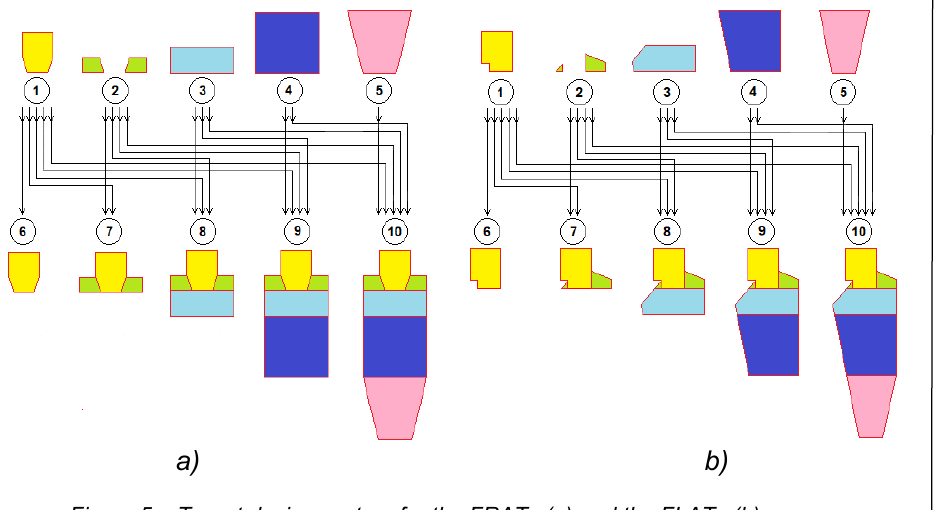
Figure 5 – Target design system for the FRATs (a) and the FLATs (b) groups Рис . 5 – Две системы построения мишеней : a) фронтально атакующих мишеней